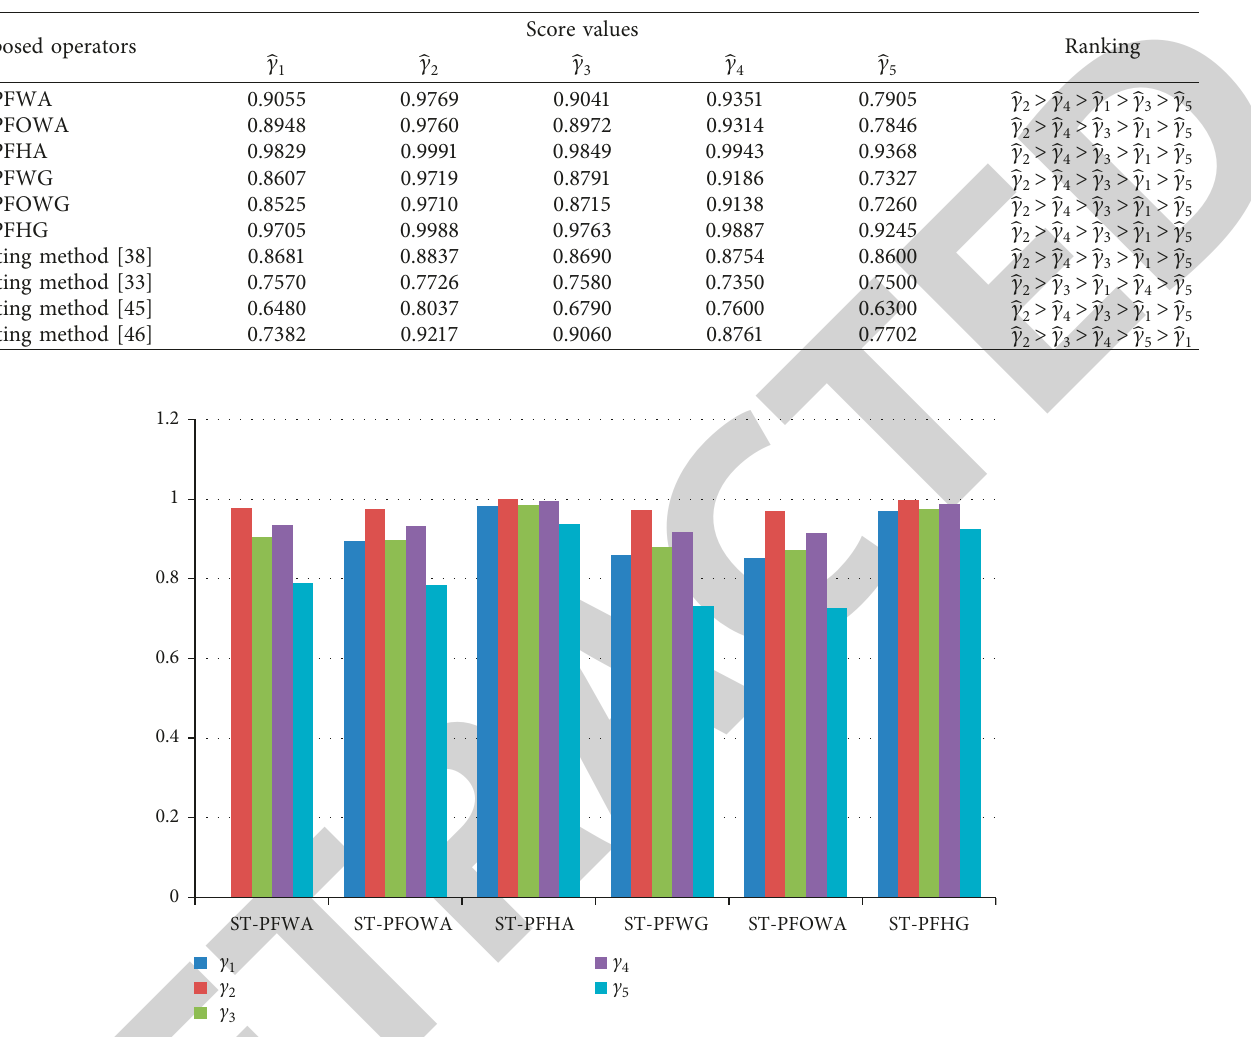
Figure 2: Graphical representation of the obtained result utilizing proposed operators and other existing